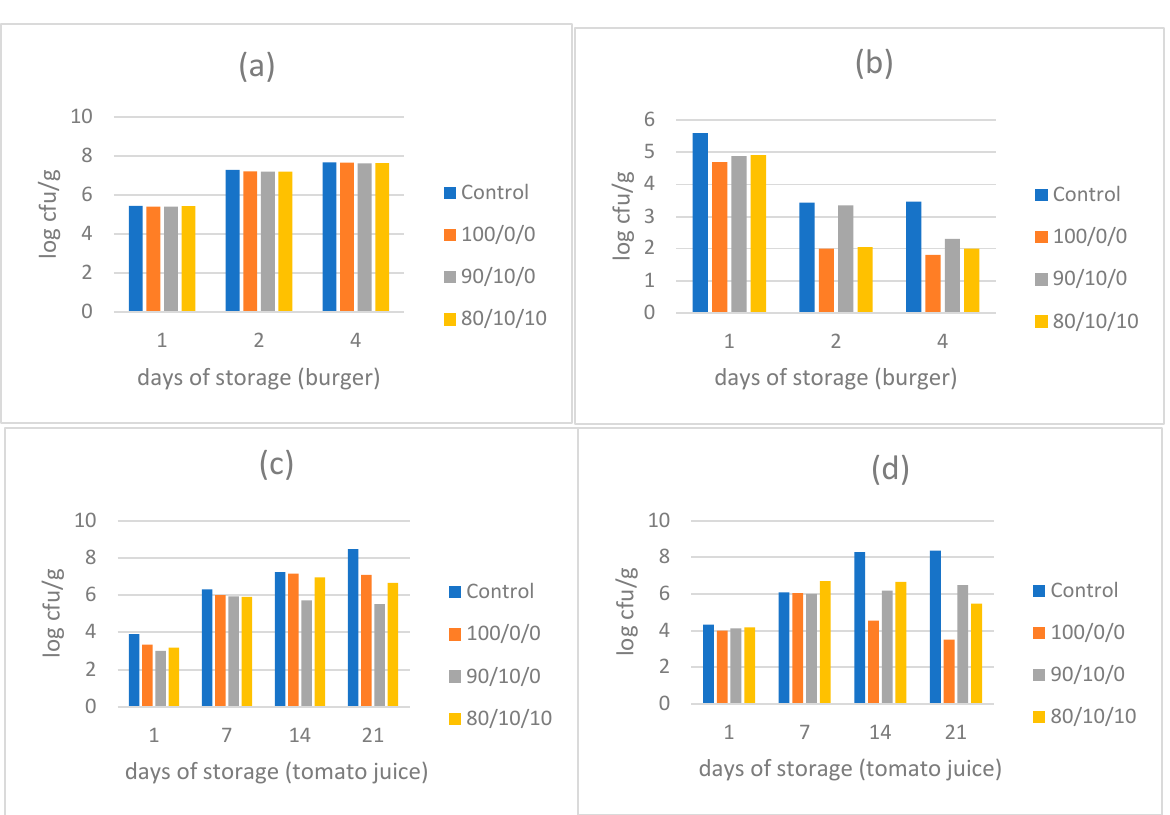
Figure 4. Populations (log cfu/g) of indigenous bacteria and fungi in two different food matrices, in the presence of selected antimicrobial powders, after appropriate storage at 4 °C. ( a ) Total Plate Count in fresh burger, ( b ) Enterobacteriaceae in fresh burger, ( c ) yeasts and molds in tomato juice, ( d ) lactic acid bacteria in tomato juice.